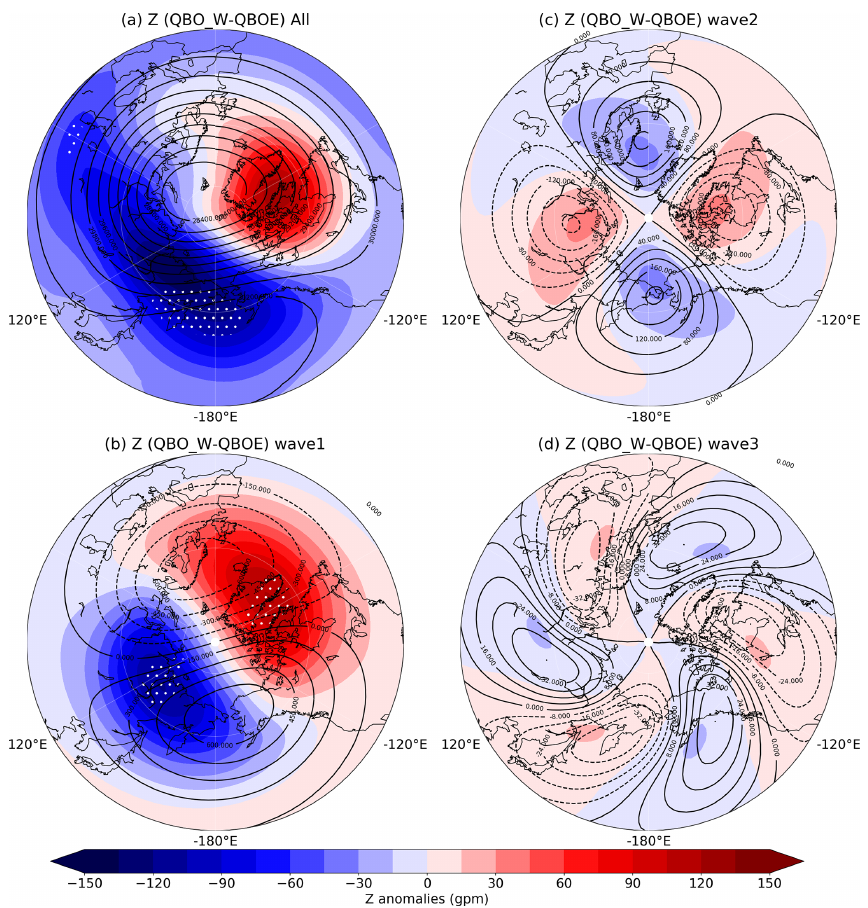
Figure 12. (a) Influences of QBO (QBOW–QBOE) on geopotential height (Z at 10hPa) in the Northern Hemisphere winter (DJF), based on ERA5 data for the period 1979–2020. (b–d) The corresponding changes in geopotential height associated with QBO in wave numbers 1–3. The climatological values of geopotential height in winter and the climatological patterns of wave numbers 1–3 during QBOE are also shown (contour lines, with contour intervals of 200, 150, 40, and 8gpm in panels (a) , (b) , (c) , and (d) , respectively). Stippled areas indicate results that are statistically significant over the 95% level, using the two-tailed Student’s t